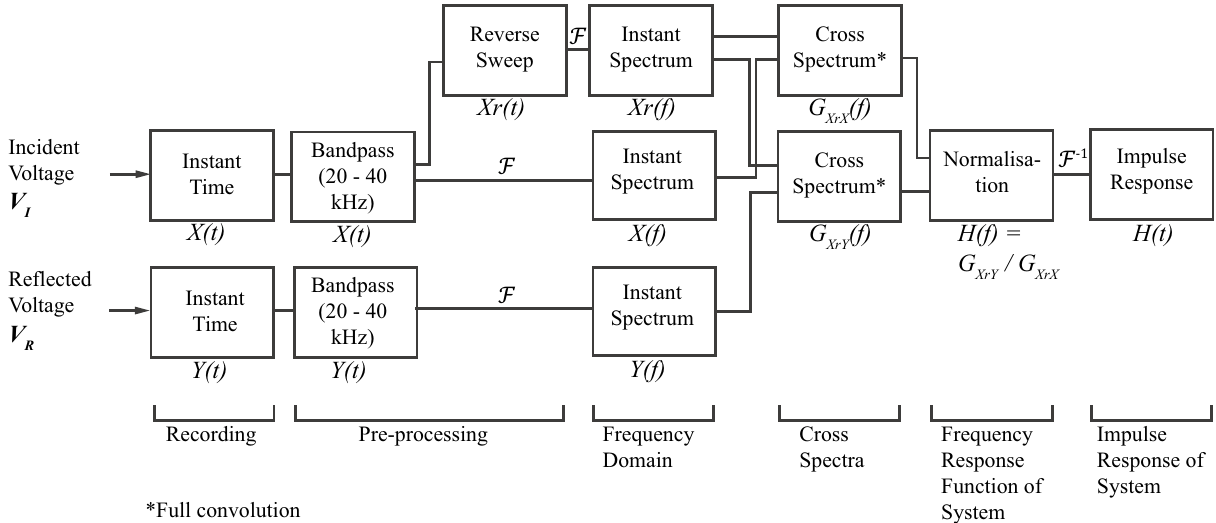
Figure 4. Measurement method of the frequency response functions (FRFs) of needle constructs. Swept-sine dual-channel measurement 25,38 was used to obtain frequency response functions ˜ H ( f ) and its impulse responses 1 H ( t ). F and F − denote a digital truncated Fourier transform operation and its inverse, respectively. ˜ G ( f ) denotes multiplication of two signals in the frequency domain, e.g. ˜ G XrX means a multiplication of the reverse sweep ˜ Xr ( f ) and the incident voltage ˜ X ( f ) signals,